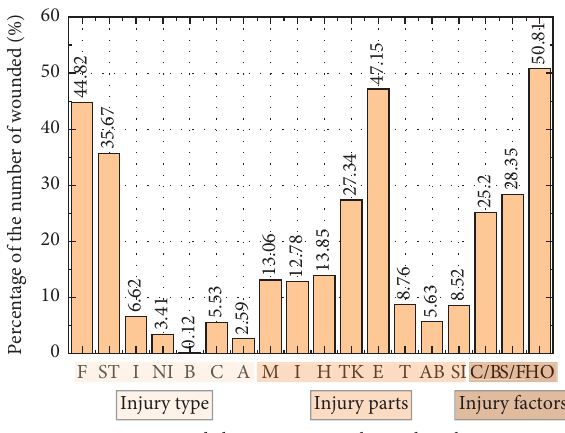
Figure 2: Injured characteristics in the